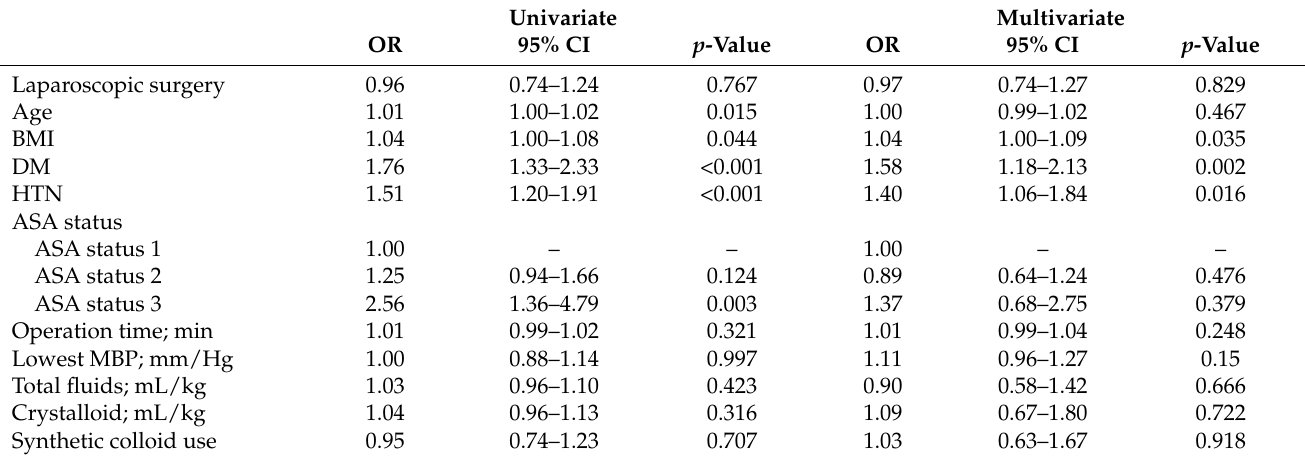
Table 4. Univariate and multivariate logistic regression analysis of AKI incidence in the unmatched